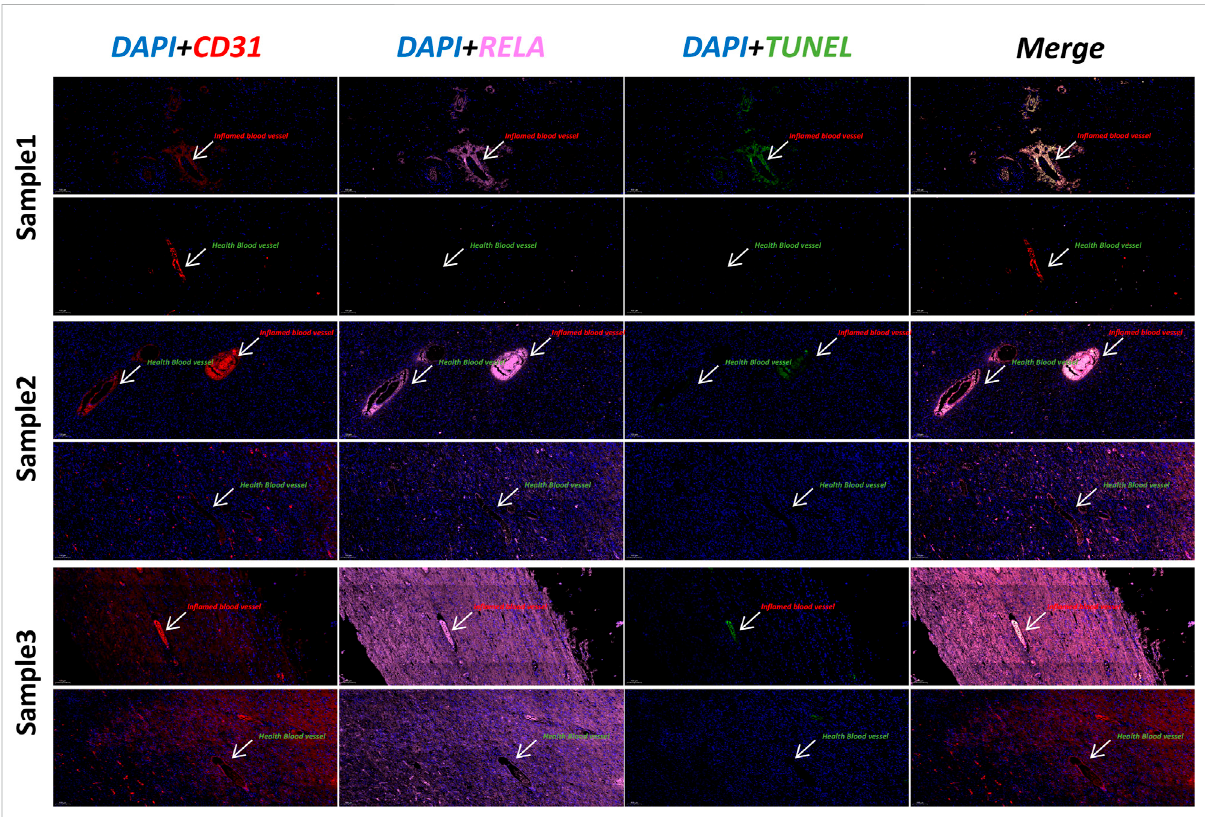
FIGURE 5 Immuno fl uorescence staining of keloid and para-keloid (DAPI/CD31/RELA/TUNEL). We used three separate samples of skin tissue for immuno fl uorescence experiments. Wefound that the TUNEL signal wasstronger in vessels with high RELA expression (In fl amedblood vessels). This result indicates that signi fi cant vascular lesions have occurred in RELA-high-expressing